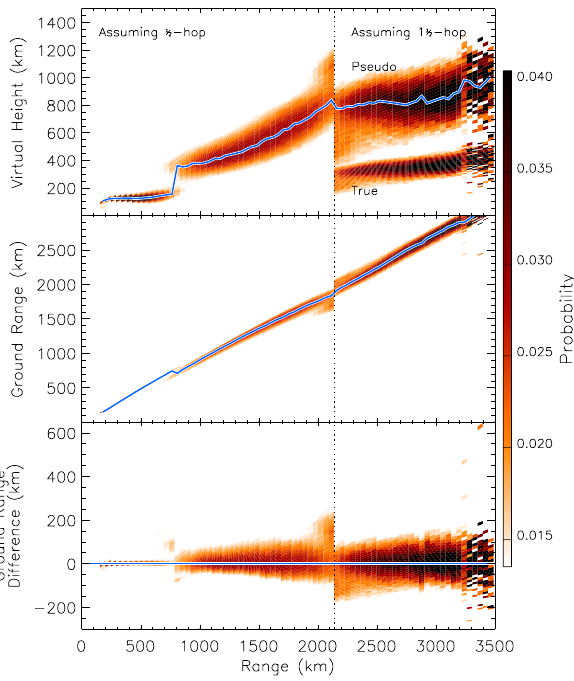
Fig. 7. A comparison of the variation of virtual height and ground range with range between the measured Saskatoon beam 3 backscat- ter distribution (colour contours) and the peak virtual height varia- tion derived from the beam 3 data set (blue line). (top) The virtual Fig. 8. Statistical histograms of range, elevation angle, fre- height distribution of Saskatoon beam 3 backscatter from 1997– quency, and magnetic local time for Saskatoon beam 3 common 2001 inclusive (adapted from Fig. 4). 1 -hop backscatter is assumed mode data from 1997–2001 inclusive, separated into 4 different fre- 2 up to a range of 2135km (vertical dotted line), whereas 1 1 -hop quency bands. The black, blue, green, and yellow curves show 2 backscatter is assumed at higher ranges. At higher ranges two the histograms for frequency ranges 10–11MHz, 12–13MHz, 13– distributions (true and pseudo) are shown, as in Fig. 5. (middle) 14MHz, and 14–15MHz, The ground range distribution for the same data set. (bottom) The ground range difference distribution showing the range of errors that result from using the peak virtual height variation as a sim- ple empirical virtual height model. Here, the blue line represents the measured distribution and the contours represent the differences that occur from using the peak virtual height variation. (all panels) Only common mode backscatter with a line-of-sight velocity mag- nitude greater than 100m/s are included. The distribution in each range bin (45km) has been normalised. The colour scale provides a key to the occurrence probability in each region; occurrence proba- bilities of less than 0.014 are shown as white space.